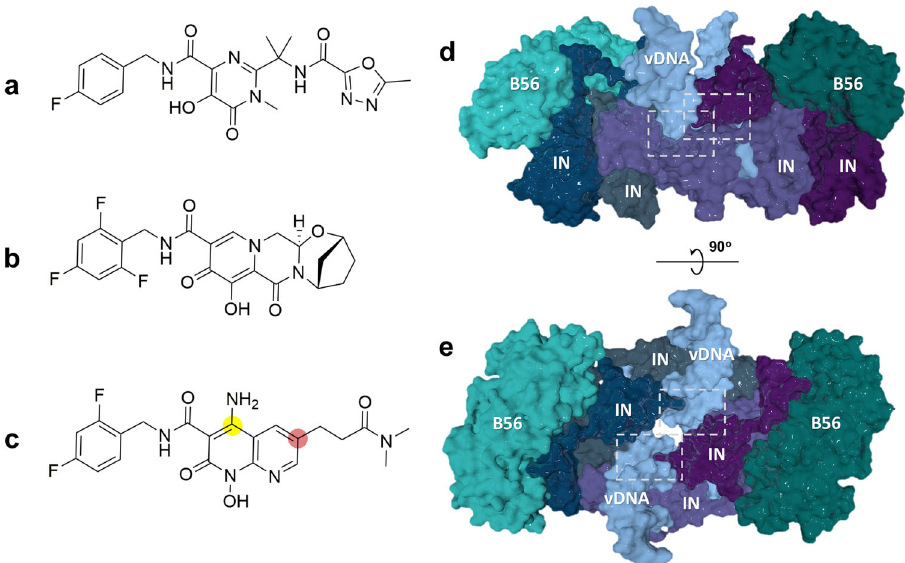
Fig. 2 Structures of the INSTIs and the STLV-1 Intasome. Chemical structures of the INSTIs used in the structural studies of binding to the deltaretroviral intasome: a Raltegravir. b Bictegravir. c XZ450. Most frequently substituted positions 4 and 6 are indicated with yellow and pink circles, respectively. d – e Overall structure of the STLV-1 intasome: RAL complex solved by cryo-EM. Each colour represents an independent integrase (IN, grey, dark blue, indigo and violet) and B56 (light and dark green) chain. Viral DNA (vDNA) is coloured light blue. Active site regions are marked with white